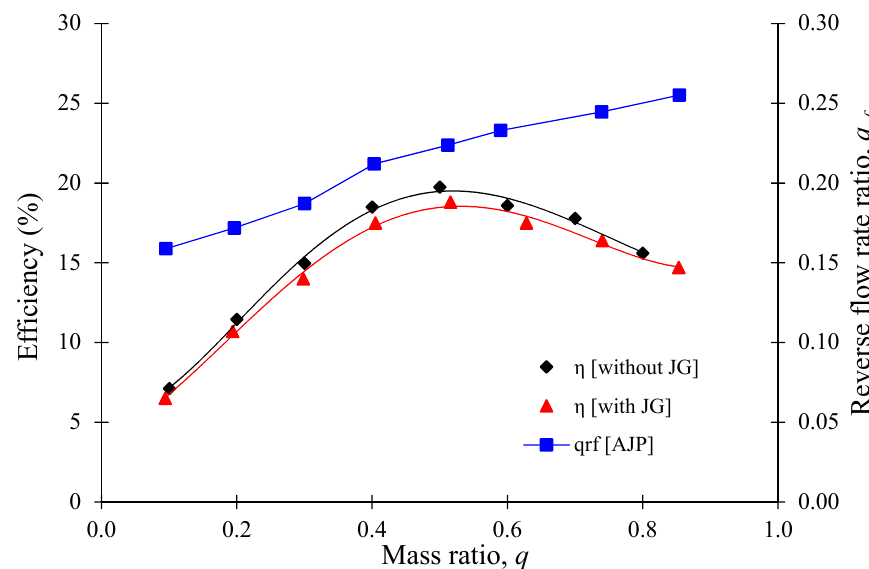
Figure 21. Performance curves of AJP model with reverse flow rate ratio.